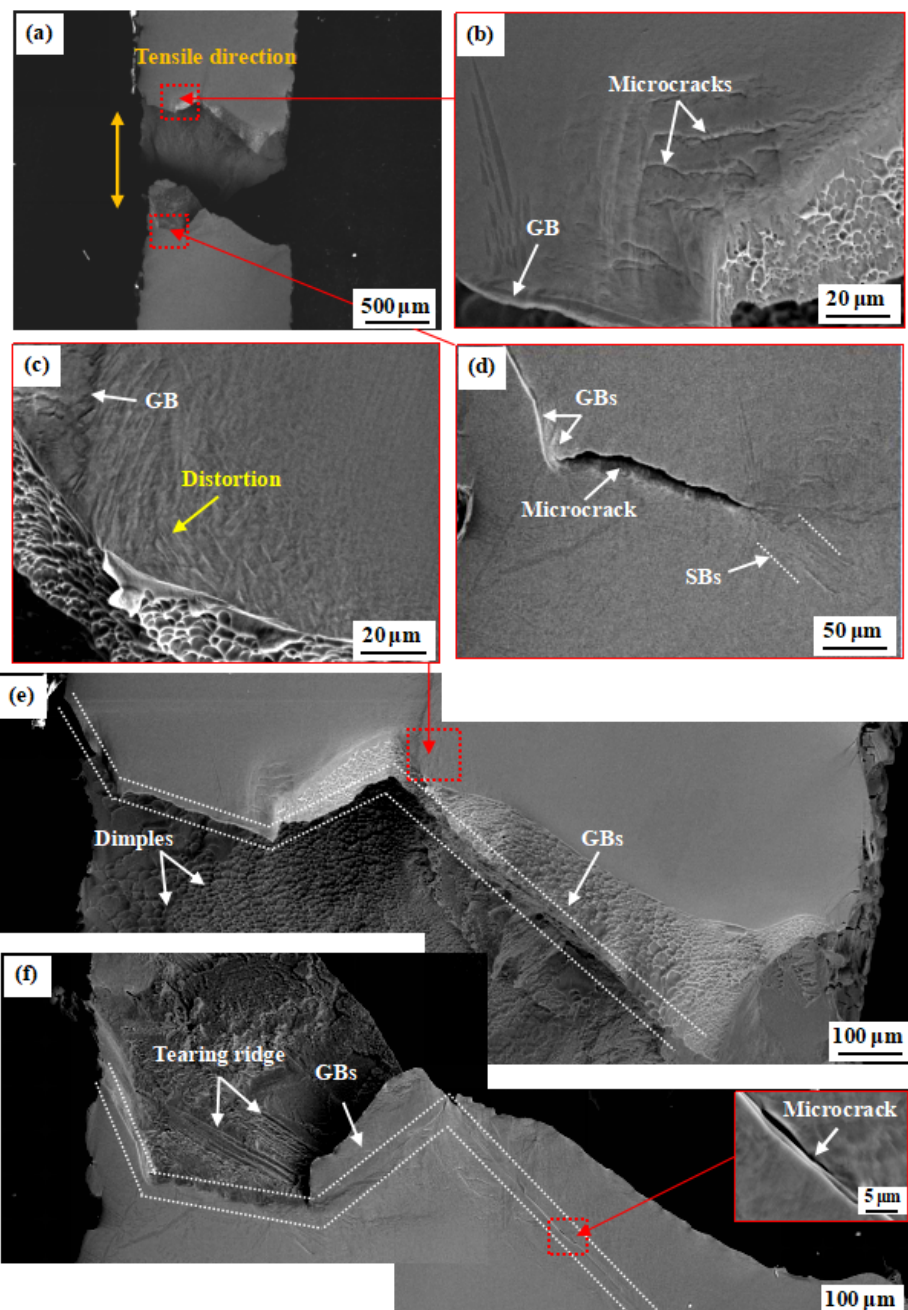
Figure 9. ( a ) In situ SEM images of lamellar microstructure at F’ (the displacement of 788 μ m); ( b , c ) microcracks and distortion occurred near the fracture area; ( d ) magnified image showing crack initiation occurred at GB; ( e , f ) SEM images showing the fracture surface of the sample.